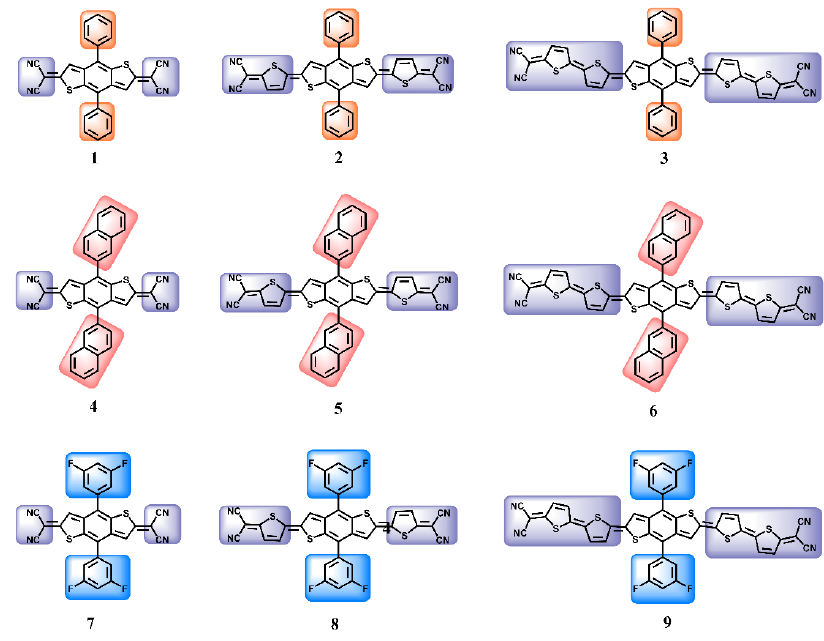
Figure 1. Chemical structures of the nine compounds (1–9).